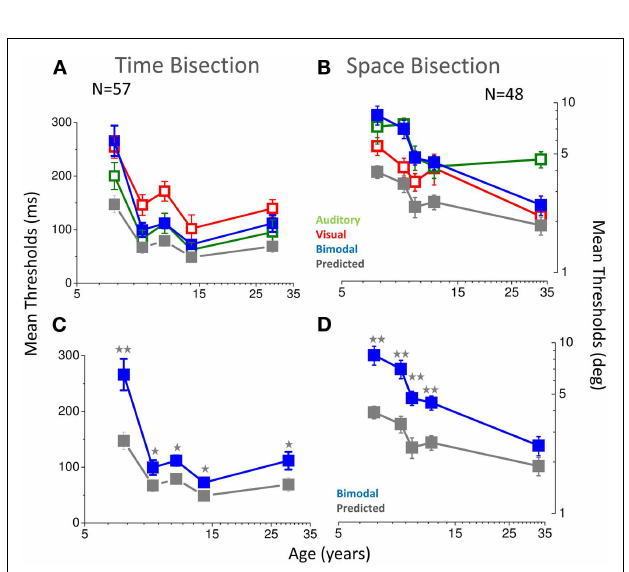
FIGURE 8 | (A) Thresholds as a function of age for the temporal bisection task.Visual thresholds are reported in red, auditory in green, bimodal in blue, and predictions of the Bayesian model in gray. (B) Same for the space bisection task. (C) Same as A, showing for clarity only bimodal thresholds (blue) and Bayesian prediction (gray). (D) Same as C for the space bisection task. In all cases, two stars represent a significance level of less than 0.01 and one star a significance level of less than 0.05 in a one tailed one sample t